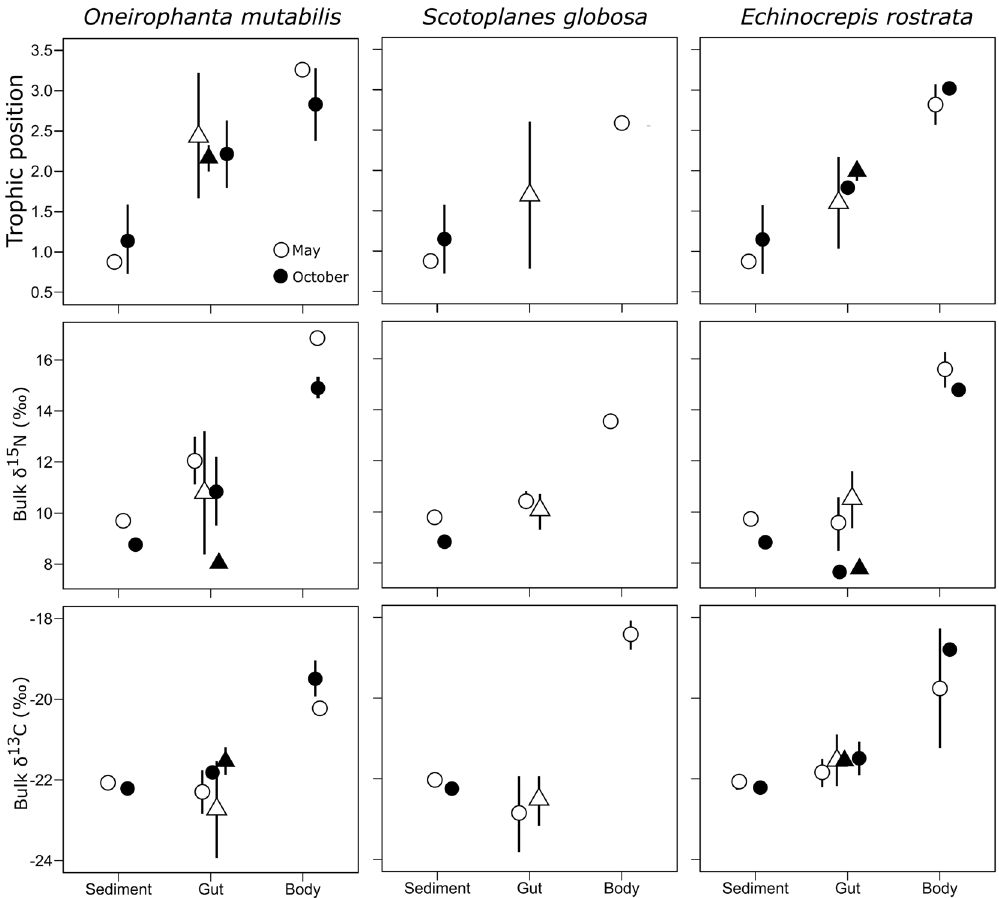
Figure 1. Trophic position, bulk δ 15 N and δ 13 C values for O. mutabilis , S. globosa and E. rostrata , their gut contents and the surrounding sediments, collected in the period of low food supply (i.e. May; open symbols) or in the period of high food supply (i.e. October; closed symbols). Within gut contents samples foregut (circles) or hindgut (triangles) are shown separately. Note that the same data from sediments are represented in all columns for comparison.